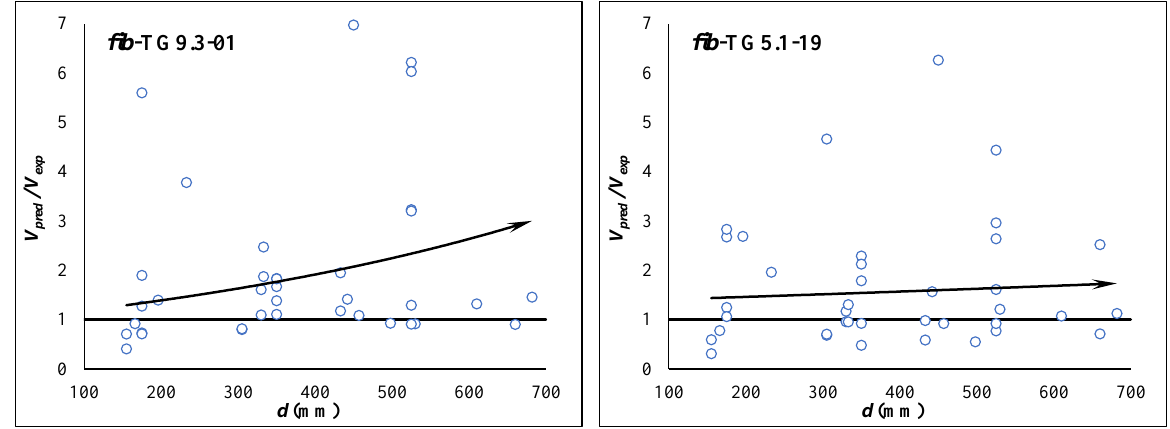
Figure 9. Influence of size effect on V pred / V exp ratio.